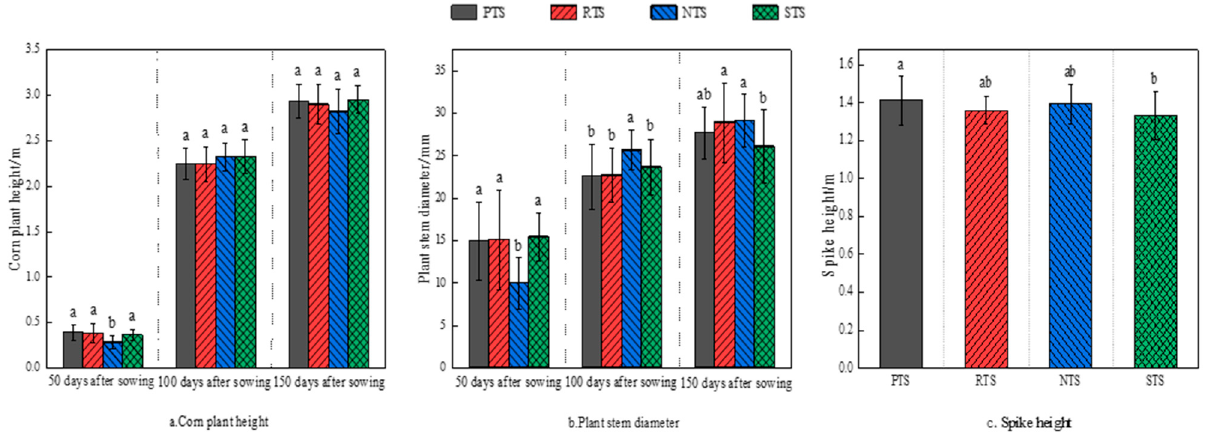
Figure 5. Changes in crop growth under different tillage and sowing methods.Note: PTS—plow tillage and sowing; RTS—rotary tillage and sowing; NTS—no-tillage and sowing; STS—no-tillage and precise sowing in stubble field. Different small letters indicate that there are significant differences between different tillage and sowing methods at the same test time ( p < 0.05). The same below.